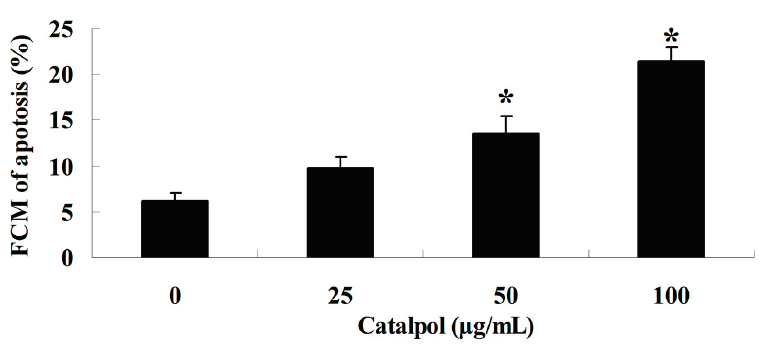
Figure 3. The apoptosis by catalpol. * p < 0.01 compared with 0 mg/mL catalpol treatment